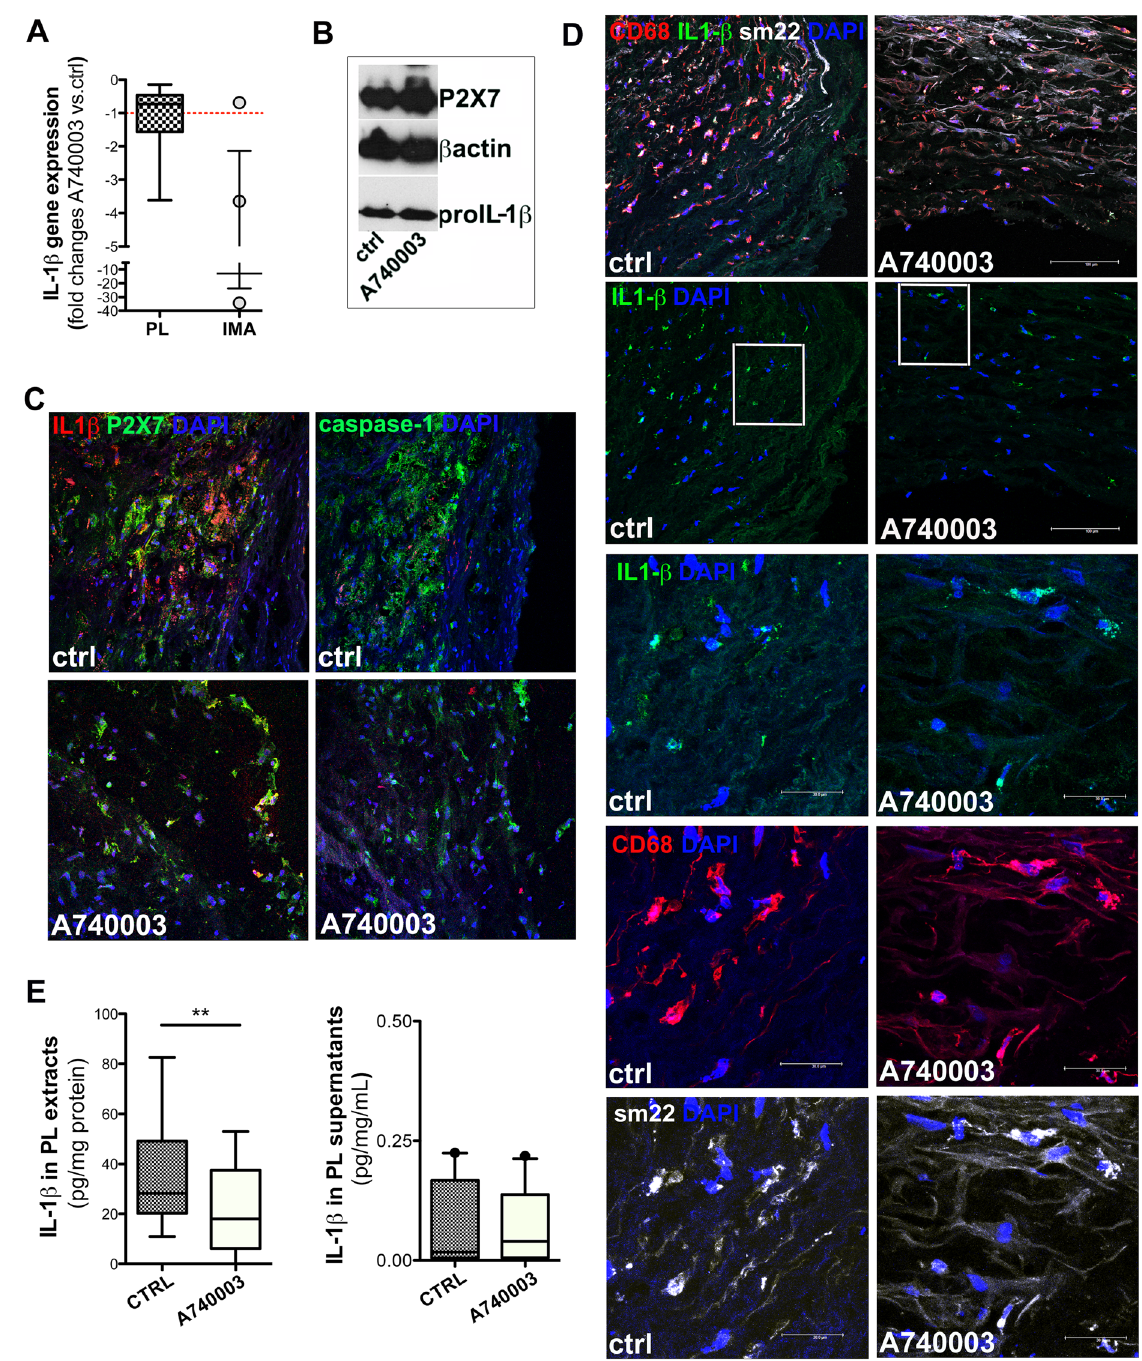
Figure 3. Ex-vivo vessels culture at t1: A740003 effects on IL1 β . IL-1 β gene expression at t1 in PLs (n = 15) and IMA (n = 3) treated with A740003 ( A ) is shown. Red dotted line indicates ctrl value. Representative cropped western blot shows P2X7 and pro-IL1 β expression in PLs protein extracts ( B ). Representative confocal microscopy 2D free projection max images from PLs intima are in ( C and D ). In ( C ) P2X7 (green), IL-1 β (red) and caspase-1 (green) are shown. In D upper row CD68 (red), IL-1 β (green) and sm22 (white) signals are merged. In ( D ) 2 nd row is IL-1 β and a white square indicates the regions magnified (3x zoom) in ( D ) 3–5 th rows. Nuclei are stained with DAPI (blue). IL-1 β content in extracts (n = 25) and supernatant from PL (n = 23) untreated/treated with A740003 ( E ) is displayed. Values are shown as boxes with 5–95 percentile ( • indicates outlier). Paired t-test was used. Significant difference is shown as ** p <